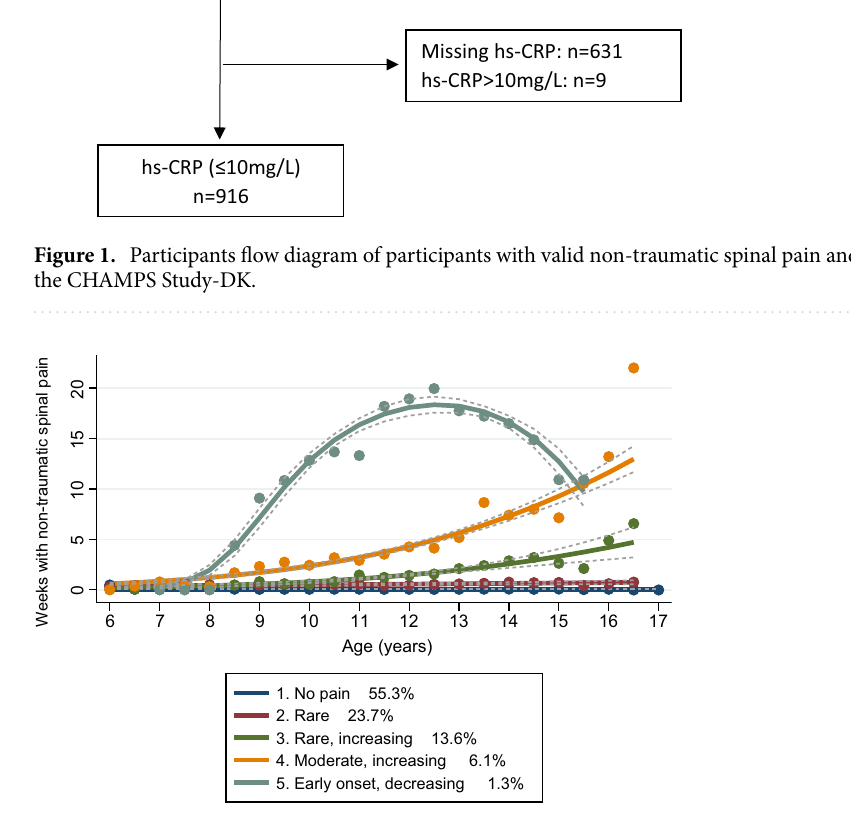
Figure 2. Non-traumatic spinal pain trajectories from 6 to 17 years of age and their prevalence (N = 1556). Points represent weeks with non-traumatic spinal pain in each 6-month period, dotted lines represent 95% confidence intervals.